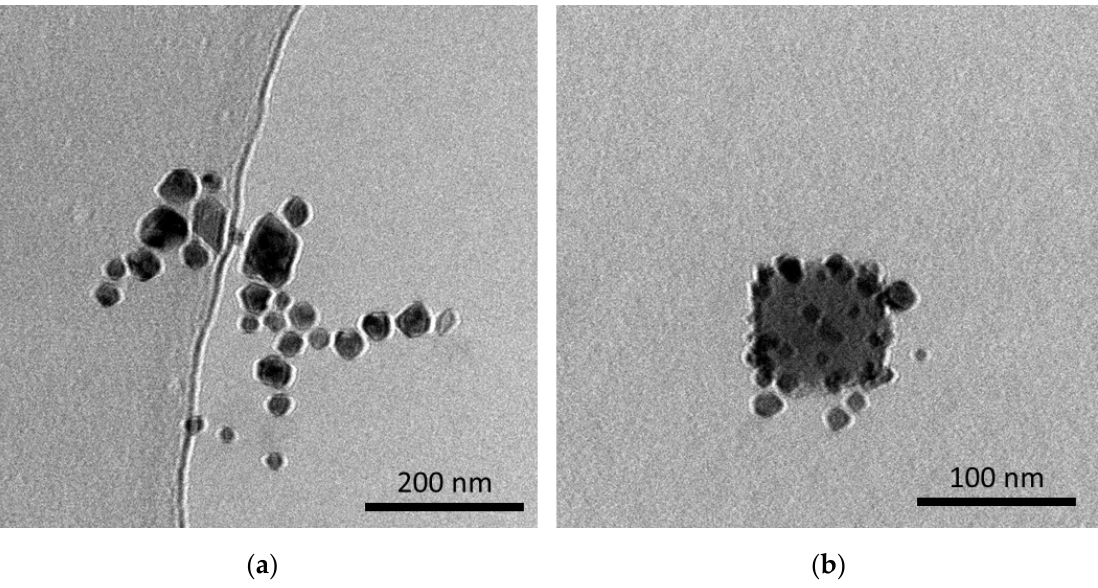
Figure 12. TEM images of the Fe 3 O 4 particles after Massart synthesis ( a ) and Fe 3 O 4 @Au nanoparticles ( b ).